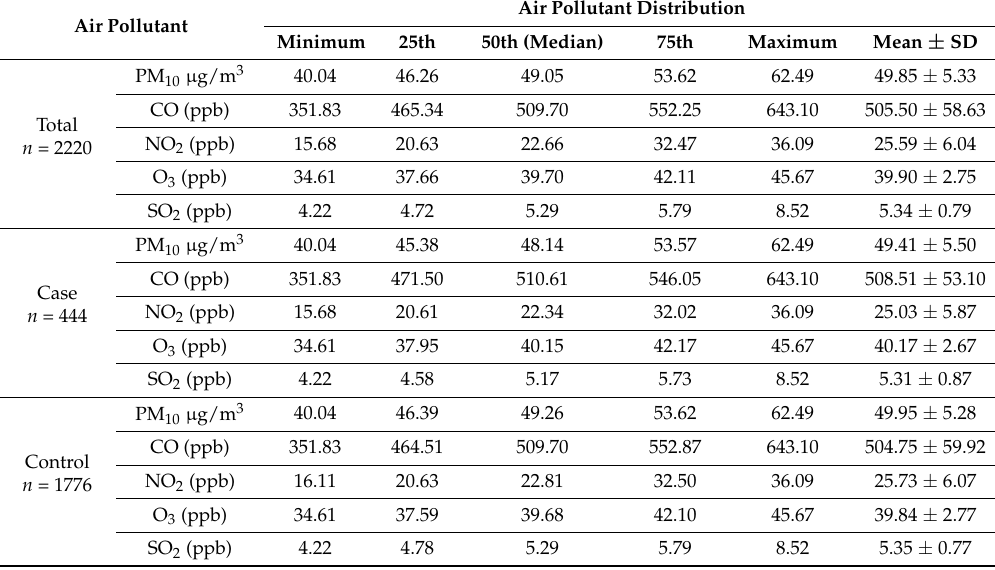
Table 2. Distribution of air pollution exposure concentrations during a one-year